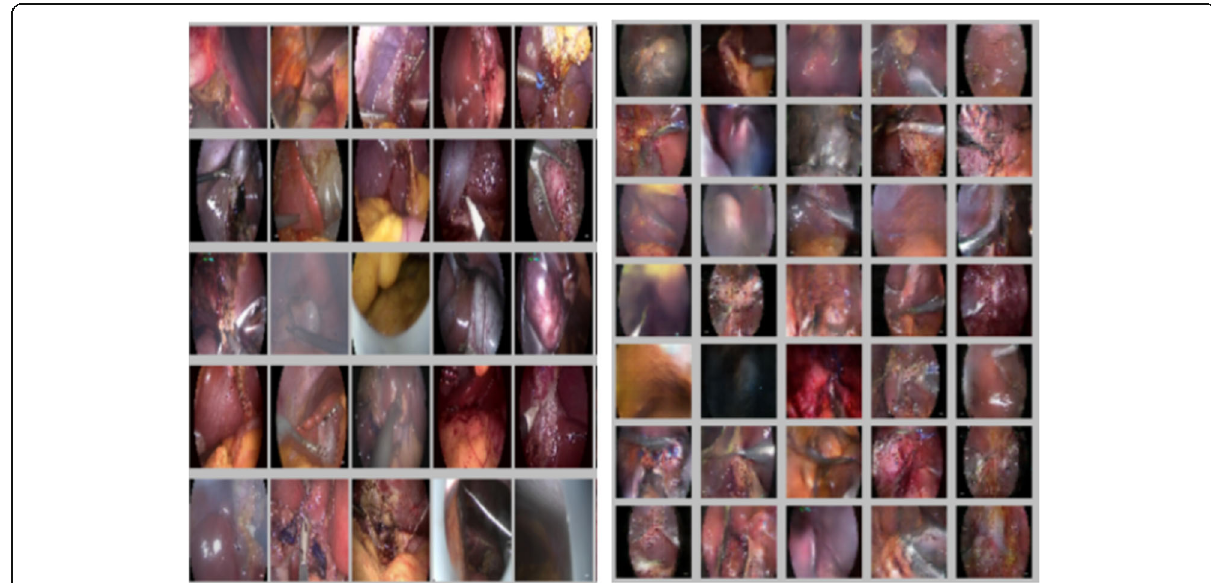
Fig. 8 (Left) Original dataset cholecystectomy surgical workflow images. (Right) Generative cholecystectomy surgical workflow